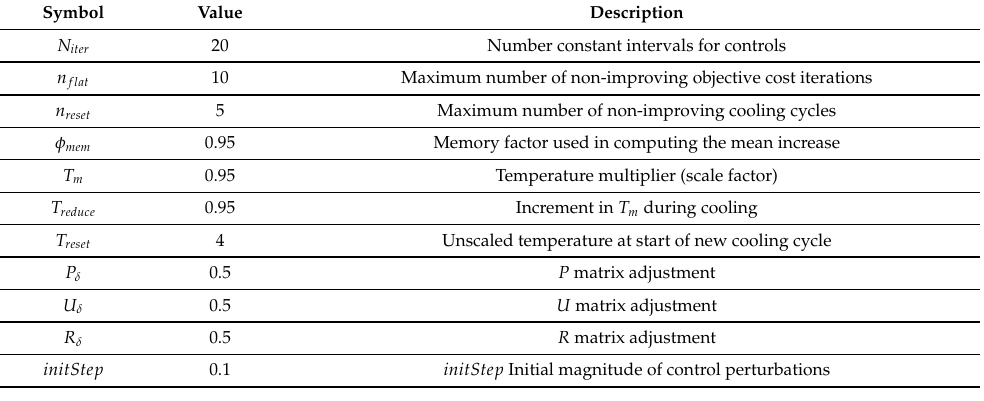
Table 3. Parameters for Monte Carlo algorithm.